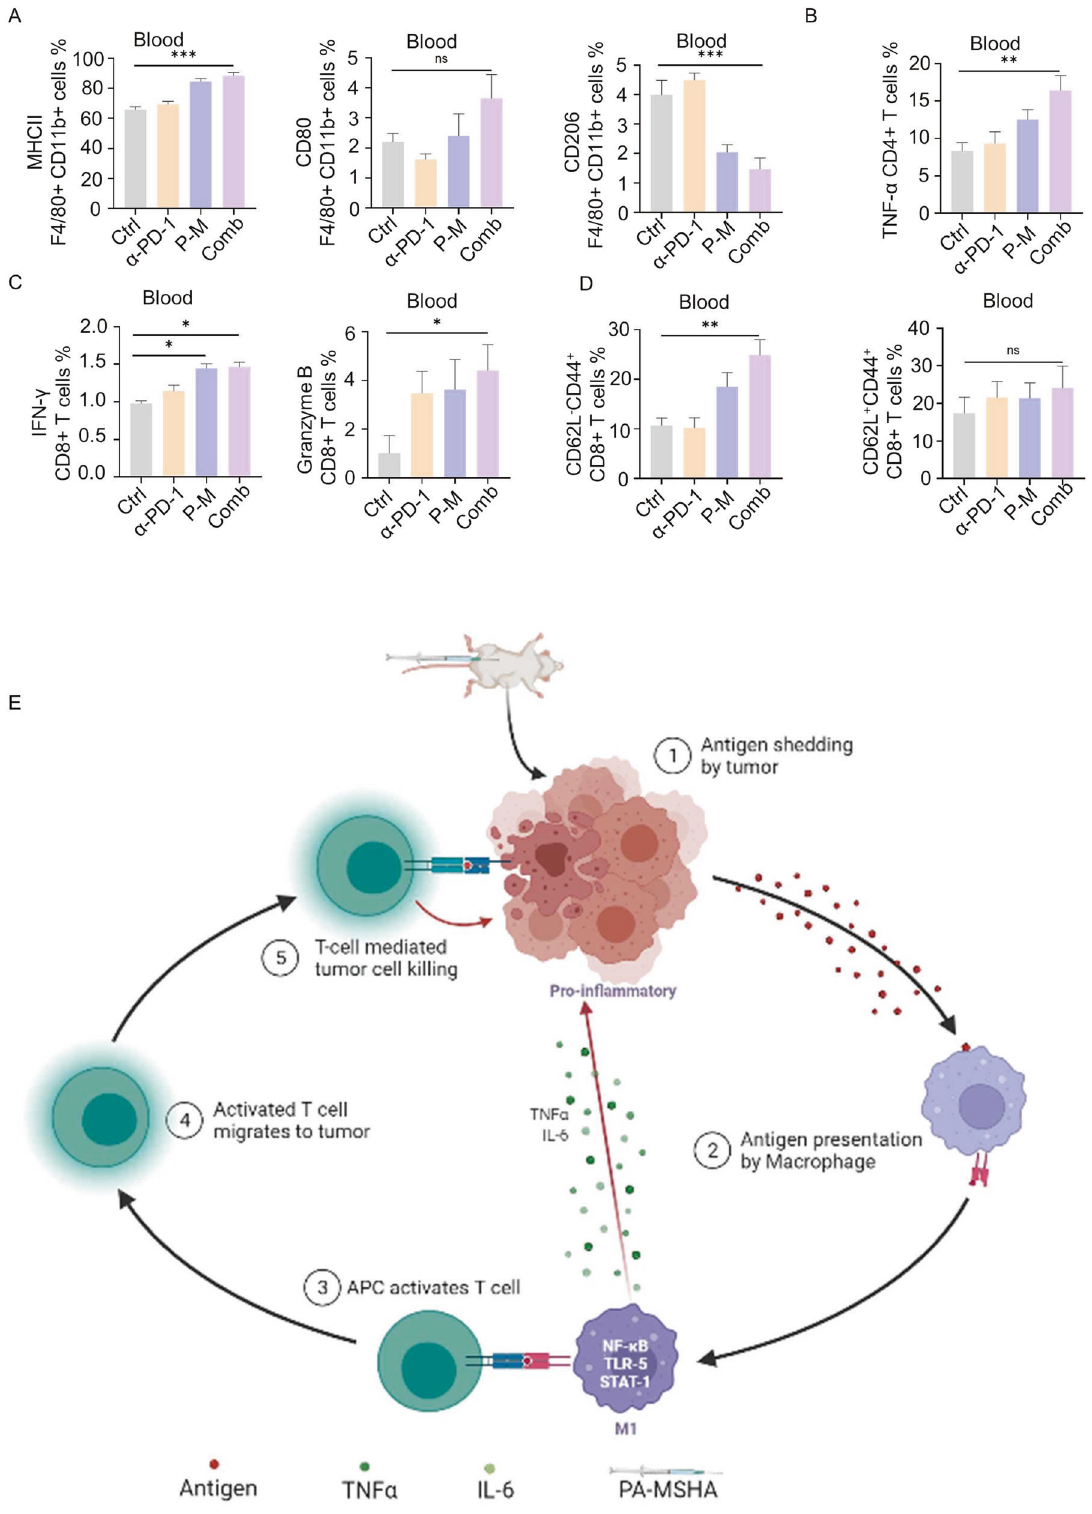
Fig. 5 PA-MSHA enhanced the anti-tumor activity of PBMC. A The expression of MHC-II and CD80 macrophages was upregulated and CD206 macrophages was downregulated in combined group. B TNF- α of CD4 + T cells, C IFN- γ and Granzyme B of CD8 + T cells in blood were all up-regulated in blood tissues after different treatments. D Flow cytometry data showed an increase in effector memory T cells (CD62L - CD44 + ) and central memory (CD62L + CD44 + ) T cells speci fi c to the CD8 + subset. E An overview schematic diagram showed how PA- MSHA modi fi es the tumor microenvironment and potentiates the antitumor effect. P-M is short for PA-MSHA. ( n = 6 mice/group, * P < 0.05, ** P < 0.01, *** P < 0.001, **** P < 0.0001.).